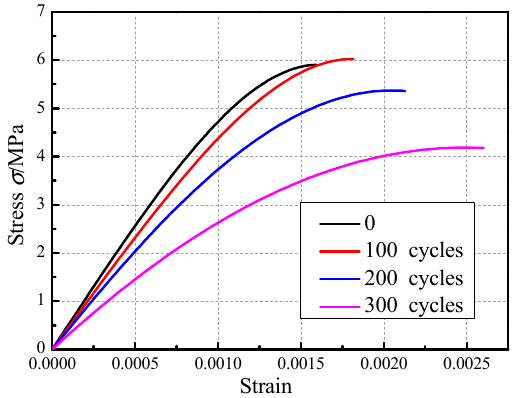
Figure 15. Stress–strain curve of the masonry prism subjected to different corrosion cycles.